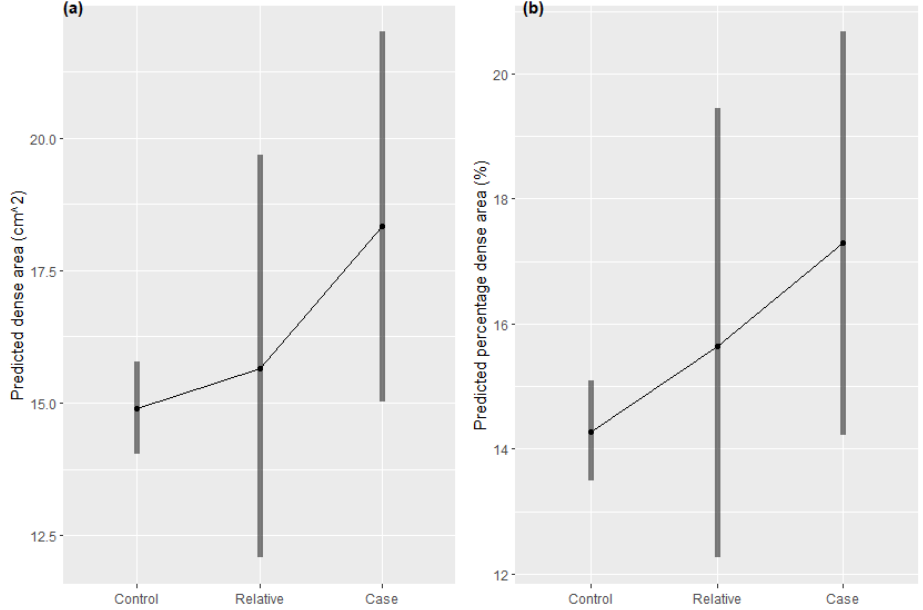
Figure 2. Estimated marginal means for dense area ( a ) and percentage dense area ( b ) adjusted for age, BMI, time between BMI measurement and mammogram, number of live births, menopause status, and the GRM by case, relative and control status for Busselton Health Study sample.